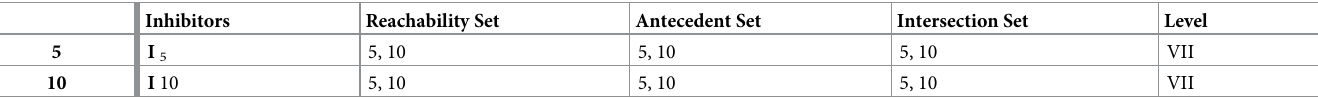
Table 13. Level partitioning iteration-7.